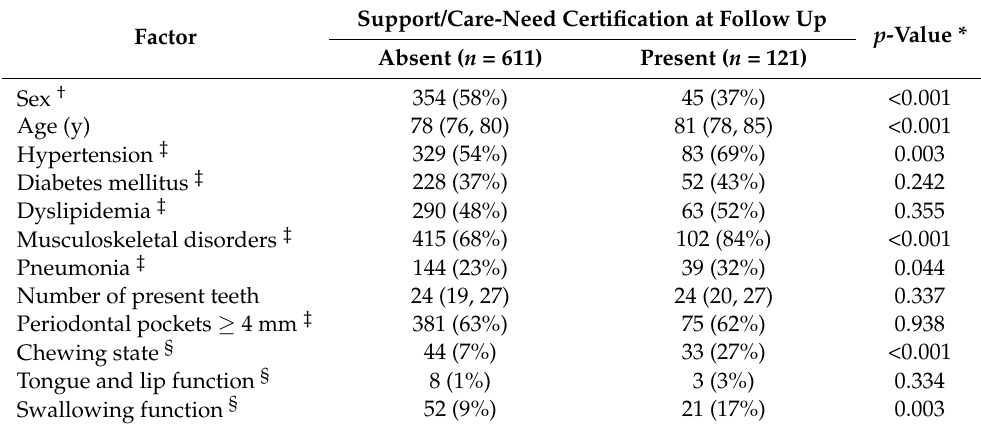
Table 2. Differences in characteristics of participants at baseline with and without support/care-need certification at follow-up.